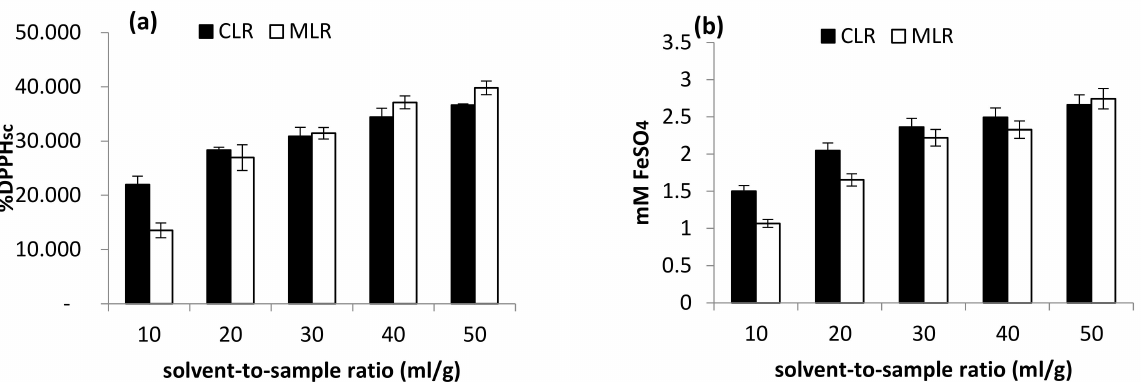
Figure 6. Effect of solvent-to-sample ratio on ( a ) DPPH scavenging activity and ( b ) ferric-reducing antioxidant power